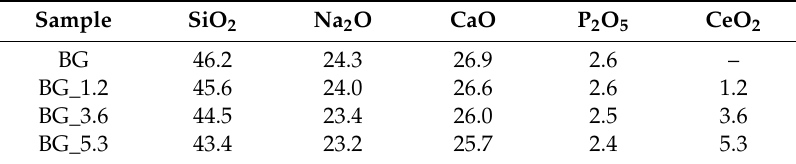
Table 1. Nominal composition (mol%) of the synthesized